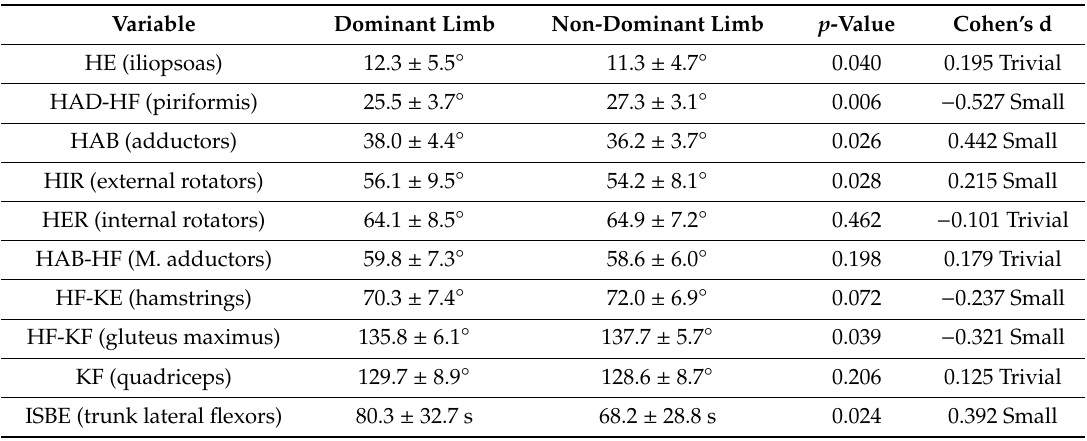
Table 2. Passive maximum lower limb range of motion and trunk lateral flexor endurance values for the 19 child equestrian athletes.